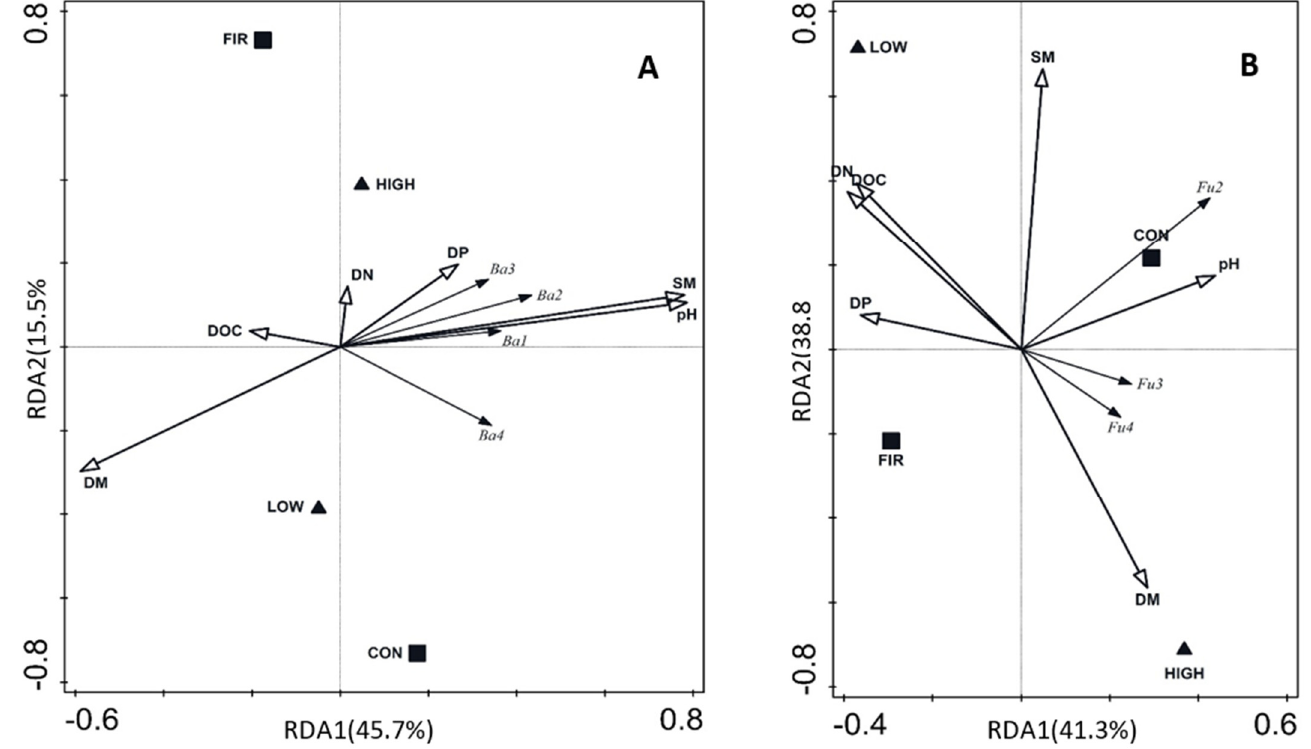
Figure 2. Ordination diagram based on RDA of the data for the total abundance of bacterivorous ( A ) and fungivorous ( B ) nematode feeding guild constituting c−p1, c−p2, c−p3, c−p4, and the environmental variables: soil pH, soil moisture (SM), dissolved phosphorous (DP), dissolved nitrogen (DN), dissolved organic carbon (DOC), and dry matter (DM) on forest sites affected by high and low severity